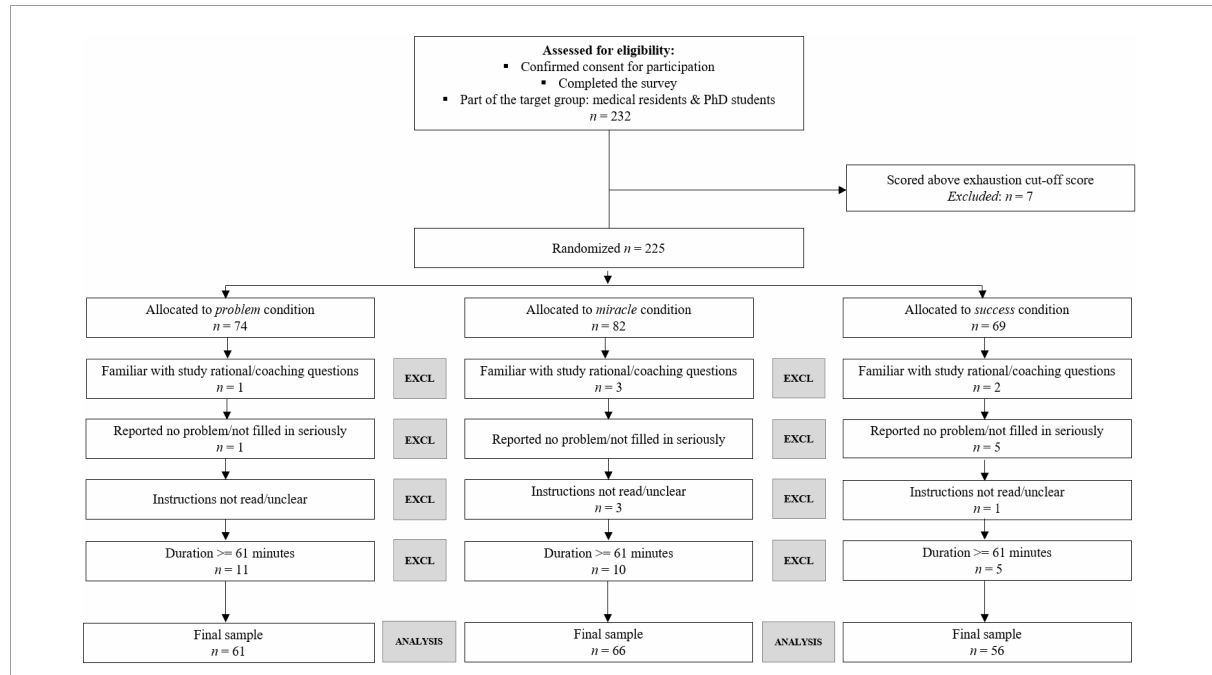
FIGURE1 CONSORT flowchart depicting screening and exclusion procedure at T1. EXCL refers to the exclusion of participants. Participants that spend 61 or more minutes on completing the experiment (i.e., extremes based on stem-and-leaf plot) were excluded, because the experimental design requires participants to complete the exercise at